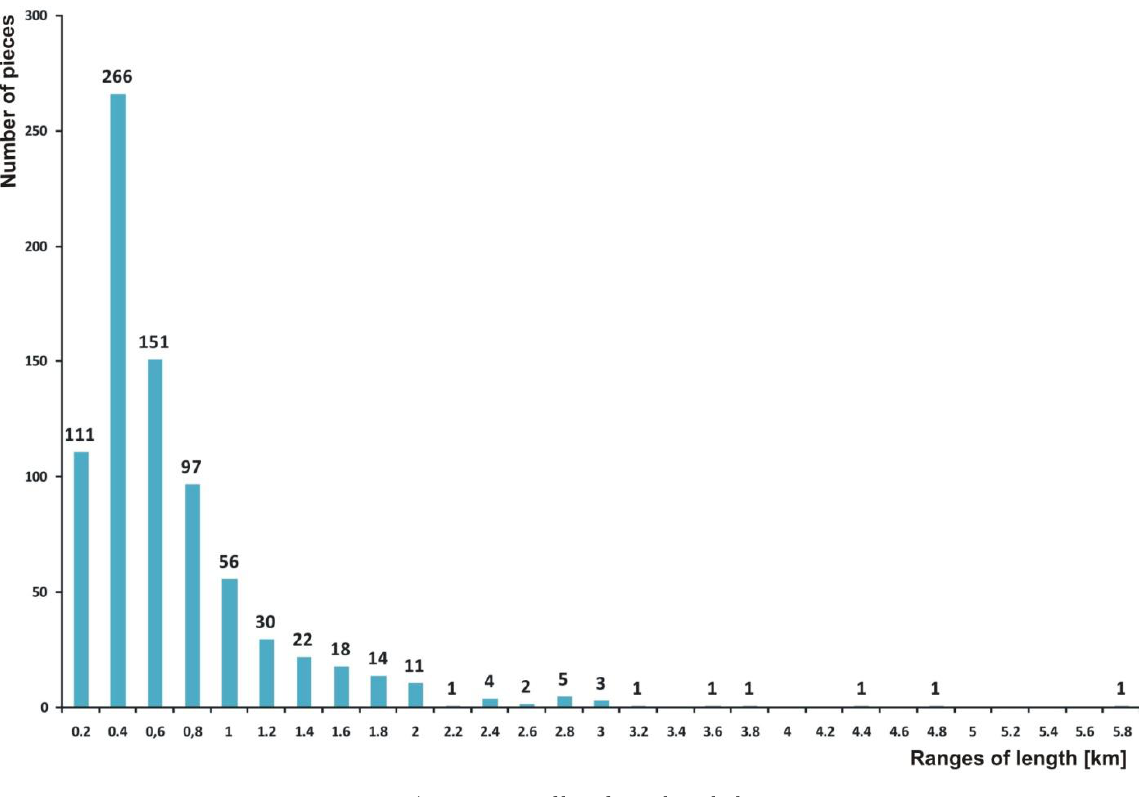
Fig. 5. Histogram of line forms length data (hexagon), 22% (circle) and 43% (triangle). This fact was not without influence on the statistical and spatial image results.